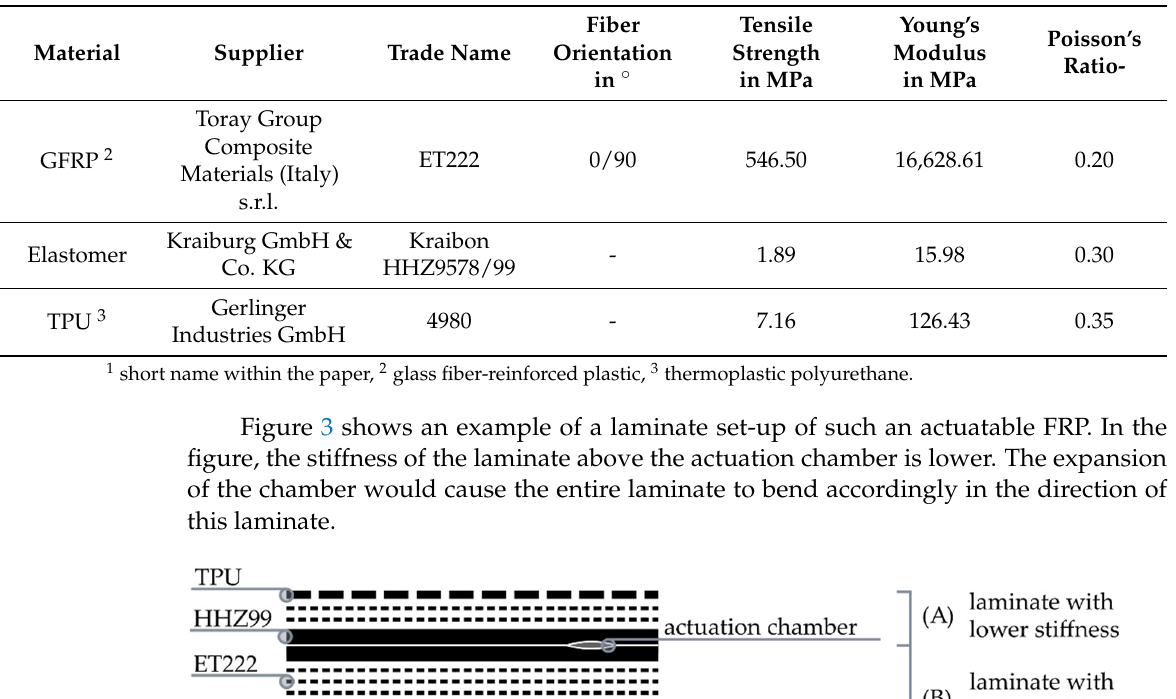
Table 1. Material properties [12].